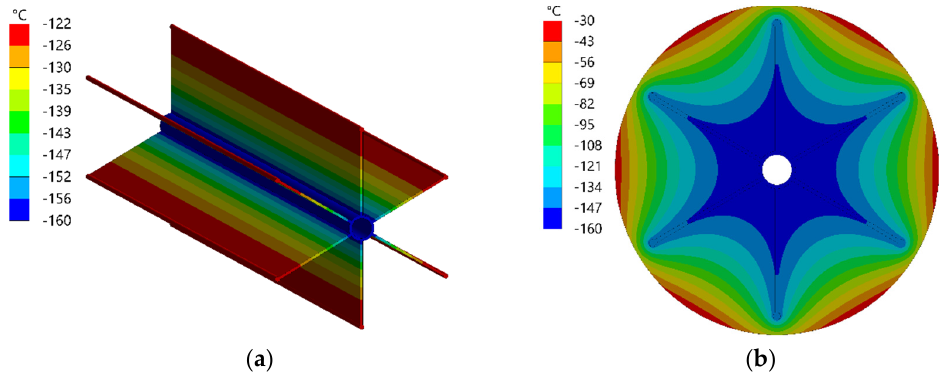
Figure9. Temperature distribution: ( a ) 6 fins—no frost, ( b ) 6 fins with frost.